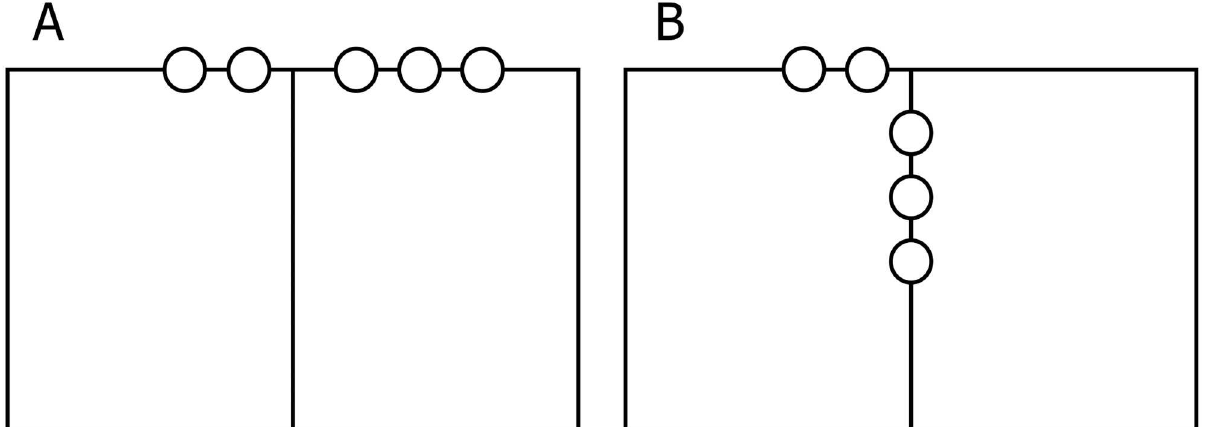
Fig 3. The introductory part of the